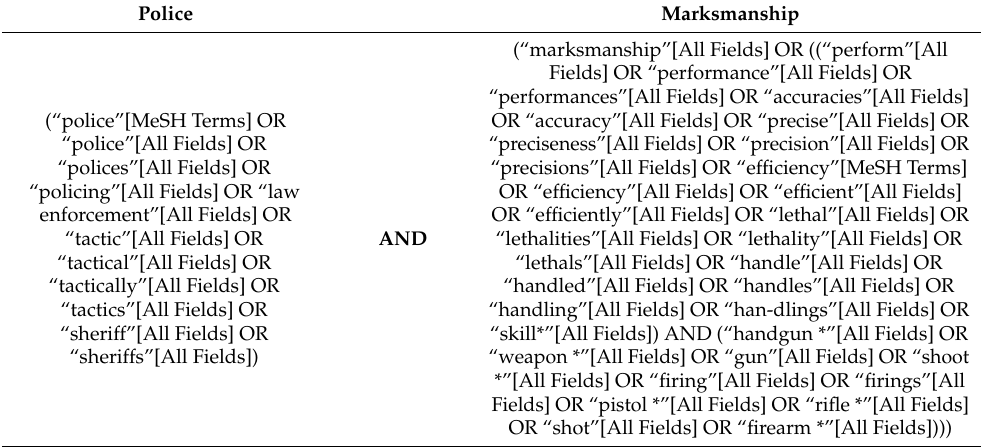
Table 2. Search terms employed to search the PubMed